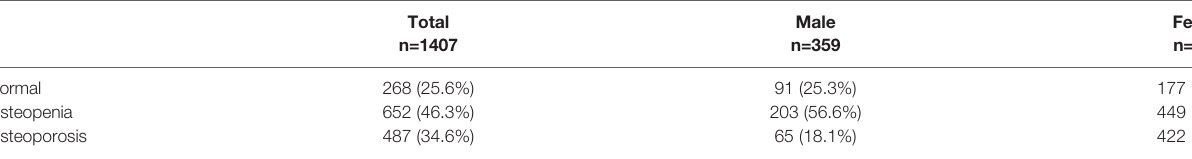
TABLE 4 | The prevalence rates of osteoporosis in participants by gender.